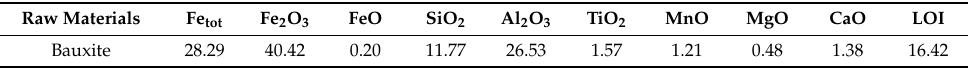
Table 1. Major element compositions of the iron rich bauxite samples.